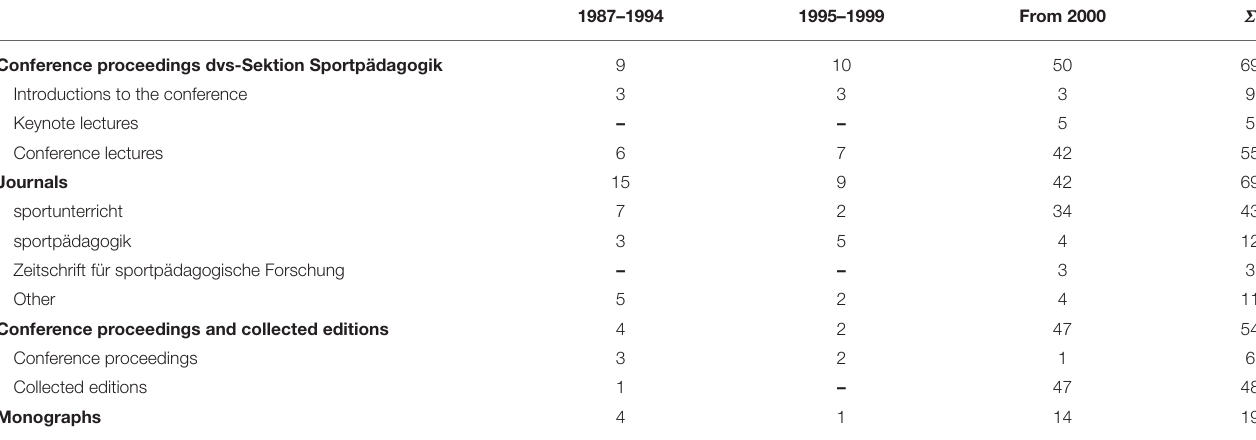
TABLE 1 | Publication overview (sorted by publication type and